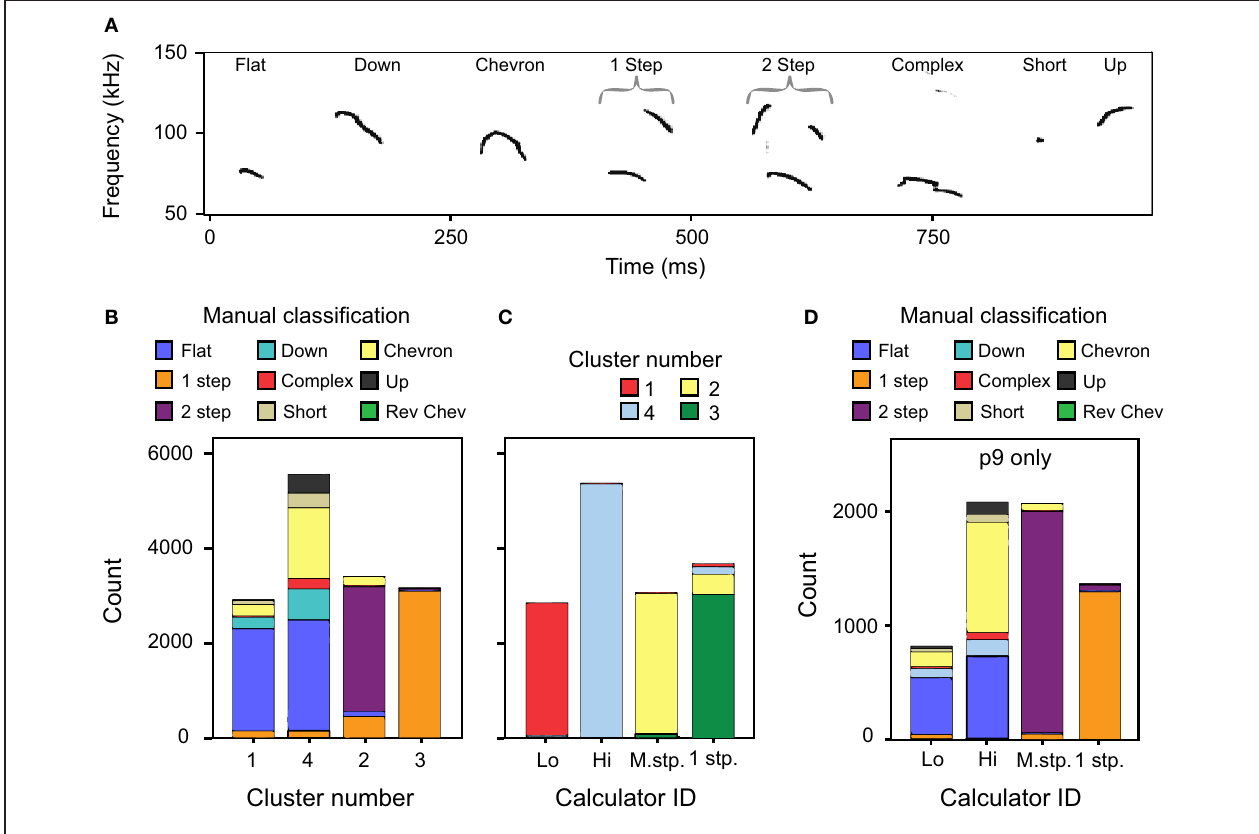
FIGURE 7 | A comparison of classification methods. (A) Spectrogram of typical examples of p4 syllables defined using manual classification (Grimsley et al., 2011). (B) Comparison between the cluster analysis and manual classifications across age. Manual classification of 1 frequency step and 2 frequency stepped syllables match well to the cluster analysis. However, manually classified syllable types with no frequency steps are split between